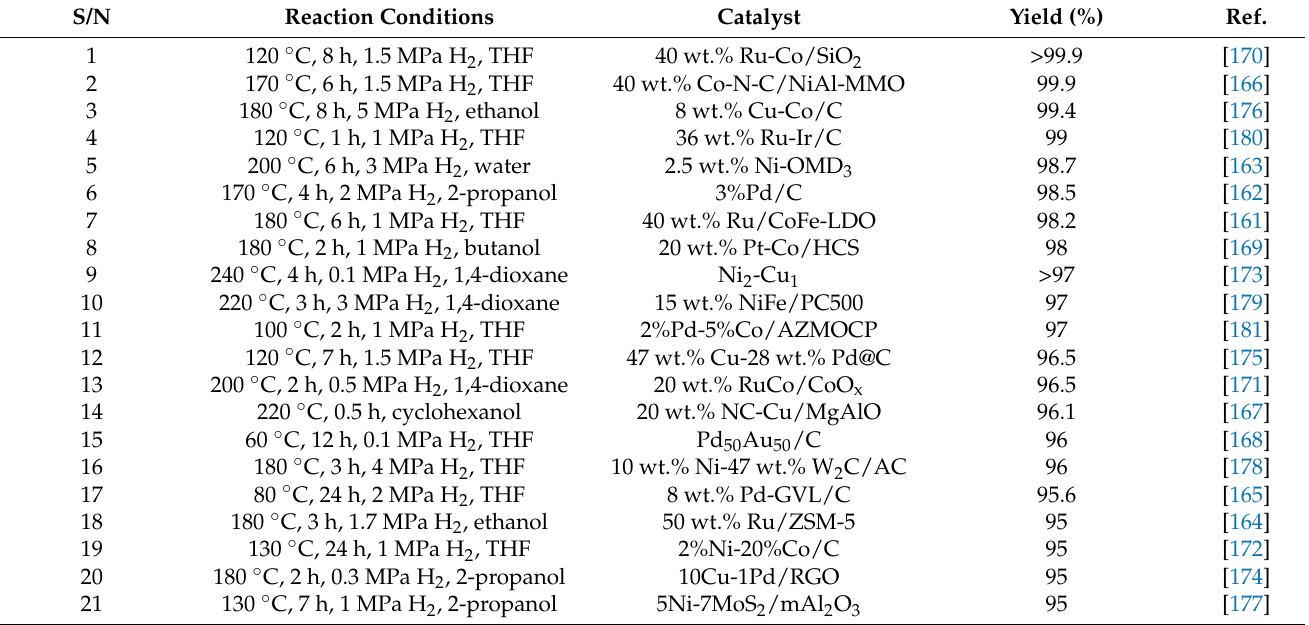
Table 4. Selected publications on the high-yielding preparation of DMF from